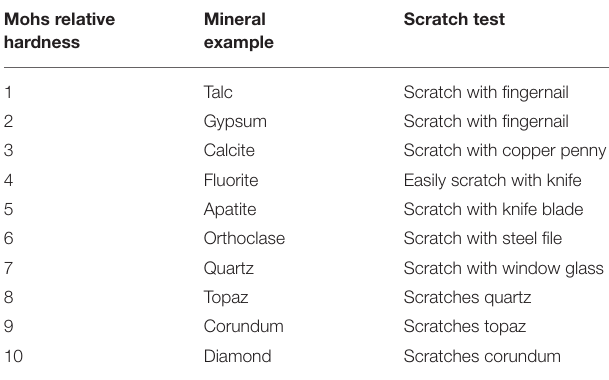
TABLE 1 | Mohs relative hardness scale, examples of minerals of each hardness level, and common tests to determine mineral hardness. Mohs relative